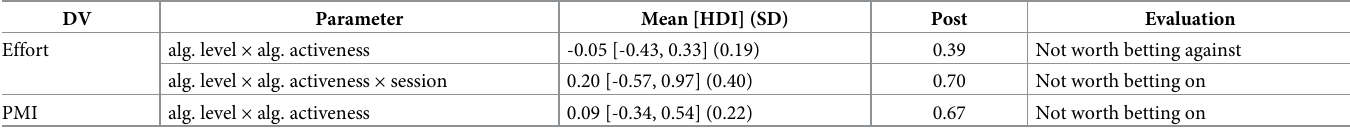
Table 8. Results of Bayesian analyses of effort and perceived motivational